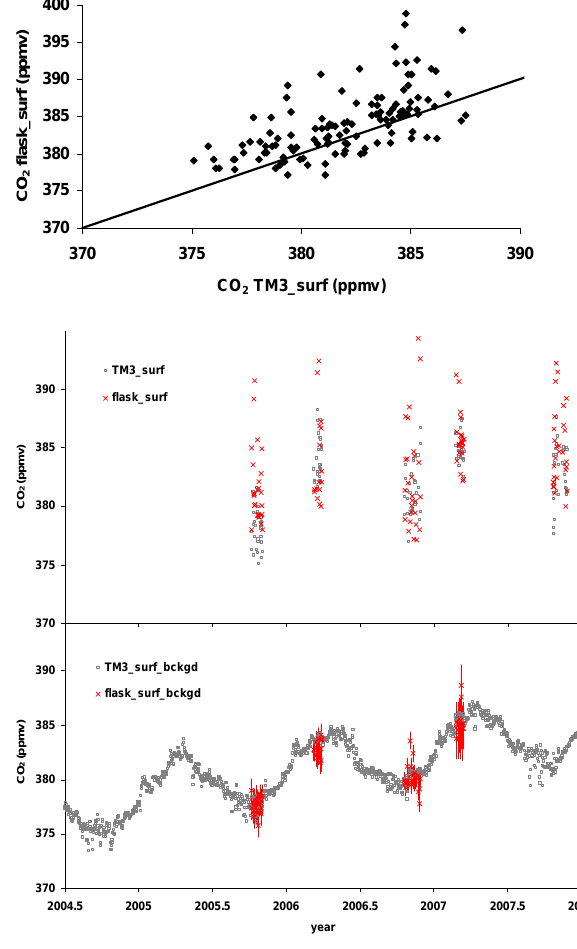
Figure 2 Fig. 2. Measured surface air mixing ratios of CO 2 compared to model simulations. CO 2 mixing ratios in surface air at Para- maribo (flask surf) vary between 377ppm and 433ppm (values above 395ppm not shown). In the upper and middle plots the flask data are compared with TM3 model simulations for the model grid containing Paramaribo (grid center 5.81 ◦ N 55.21 ◦ W). The lower panel shows model data for the adjacent model grid towards the east (grid center 5.81 ◦ N 50.21 ◦ W), mainly containing ocean compared with calculated background CO 2 . The background CO 2 mixing ra- tio (flask surf bckgd) has been calculated using linear mixing lines (Fig. 1) and a background δ 13 C from NOAA/ESRL flask measure- ments from Ascension Is. (ASC) and Ragged Point (RPB). δ 13 C values from Ascension Is. are used for the LDS-campaigns, when the air at Paramaribo belongs to the Southern Hemisphere and δ 13 C values from Ragged Point for the SDS campaigns, when the air at Paramaribo belongs to the Northern